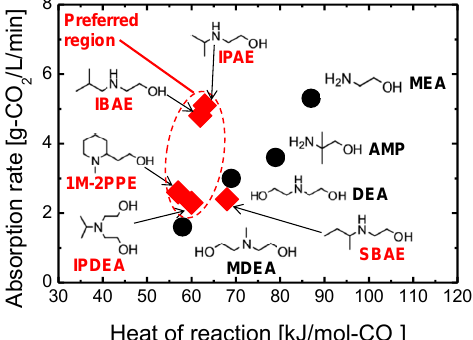
Heat of reaction [kJ/mol-CO ] Figure 1. Relationships of absorption rate and heat of reaction between conventional and synthesized Figure 1. Relationships of absorption rate and heat of reaction between conventional and synthesized Figure 1. Relationships of absorption rate and heat of reaction between conventional and synthesized 2 Figure 1. Relationships of absorption rate and heat of reaction between conventional and synthesized amines employed for CO 2 absorbents. Solid circles ( ): conventional amines with no/low steric Figure 1. Relationships of absorption rate and heat of reaction between conventional and synthesized amines employed for CO 2 absorbents. Solid circles ( ): conventional amines with no/low steric amines employed for CO 2 absorbents. Solid circles ( ): conventional amines with no/low steric amines employed for CO 2 absorbents. Solid circles ( ): conventional amines with no/low steric hindrance. Figure 1. Relationships of absorption rate and heat of reaction between conventional and synthesized hindrance. Solid diamond ( ): synthesized amines with sterical hindrance. Abbreviations: MEA , 2- amines employed for CO 2 absorbents. Solid circles ( ): conventional amines with no/low steric hindrance. Solid diamond ( ): synthesized amines with sterical hindrance. Abbreviations: MEA , 2- hindrance. Solid diamond ( ): synthesized amines with sterical hindrance. Abbreviations: MEA , 2- Solid diamond ( amines employed for CO 2 absorbents. Solid circles ( ): conventional amines with no/low steric aminoethanol; AMP , 2-amino-2-methyl-1-propanol; DEA , diethanolamine; MDEA , hindrance. Solid diamond ( ): synthesized amines with sterical hindrance. Abbreviations: MEA , 2- aminoethanol; hindrance. Solid diamond ( ): synthesized amines with sterical hindrance. Abbreviations: MEA , 2- aminoethanol; methyldiethanolamine; IPAE , 2-(isopropylamino)ethanol; IBAE , 2-(isobutylamino)ethanol; SBAE , 2- aminoethanol; AMP , 2-amino-2-methyl-1-propanol; DEA , diethanolamine; MDEA , aminoethanol; AMP , (secondarybutyamino)ethanol; IPDEA , 2-(isopropyl)diethanolamine; 1M-2PPE , 1-Methyl-2- methyldiethanolamine; IPAE , 2-(isopropylamino)ethanol; IBAE , 2-(isobutylamino)ethanol; SBAE , 2-